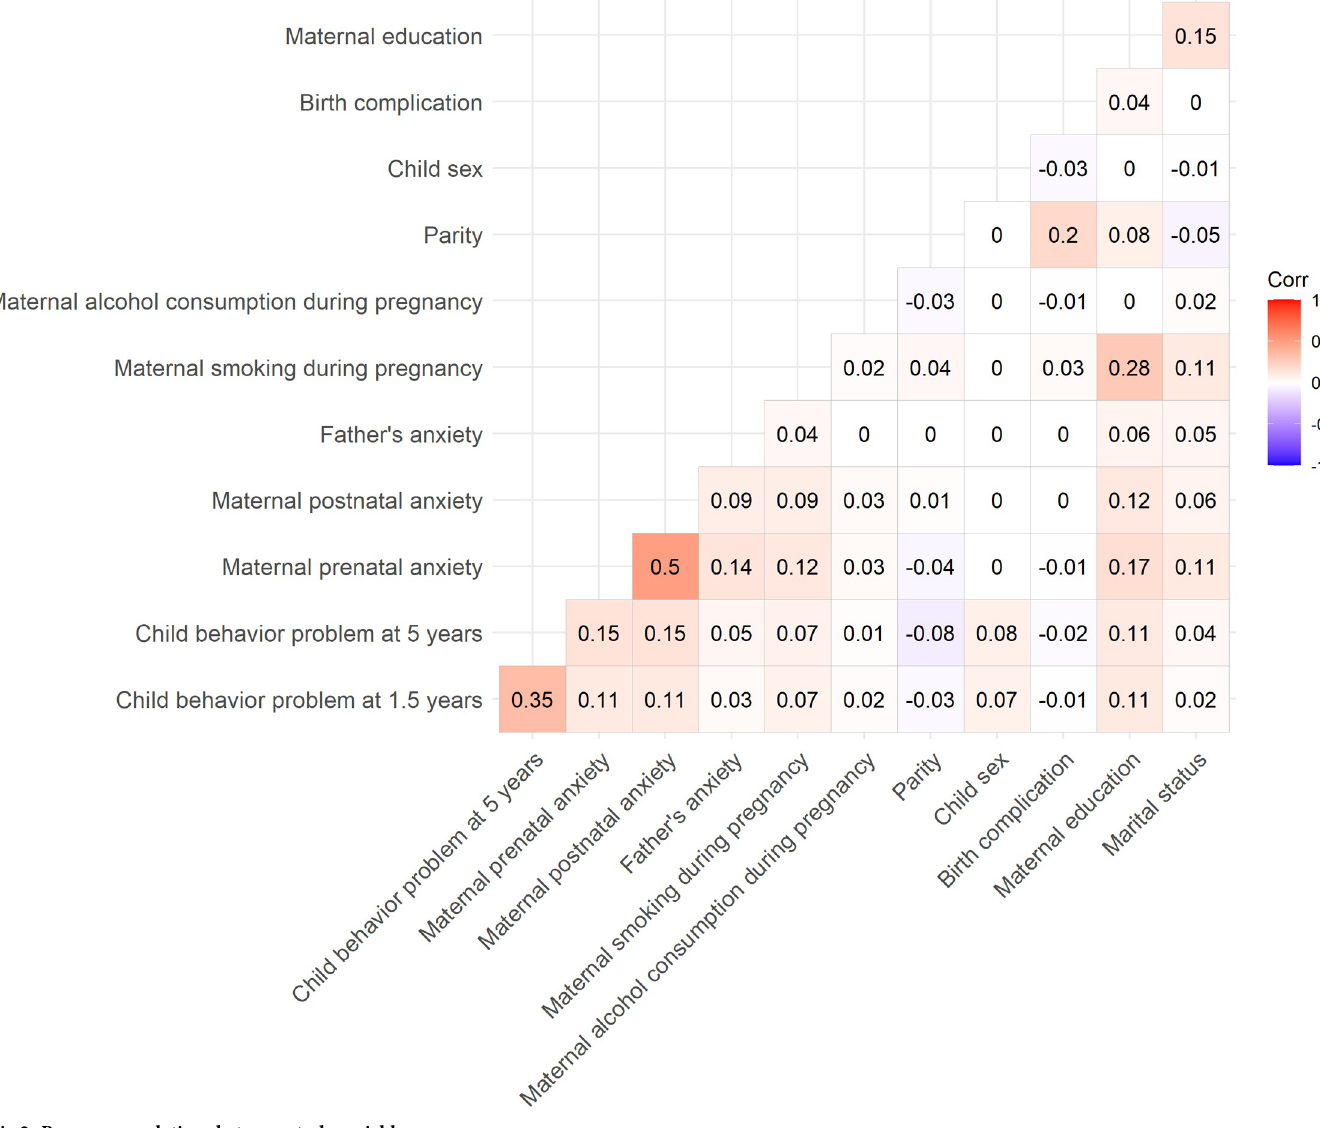
Fig 2. Pearson correlations between study